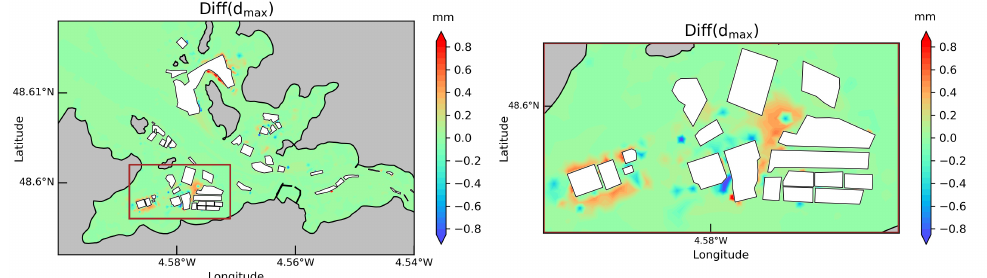
Figure 17. Differences in maximum diameters of bed sediments liable to be moved in mean spring tidal conditions between simulations E 3 and E 2